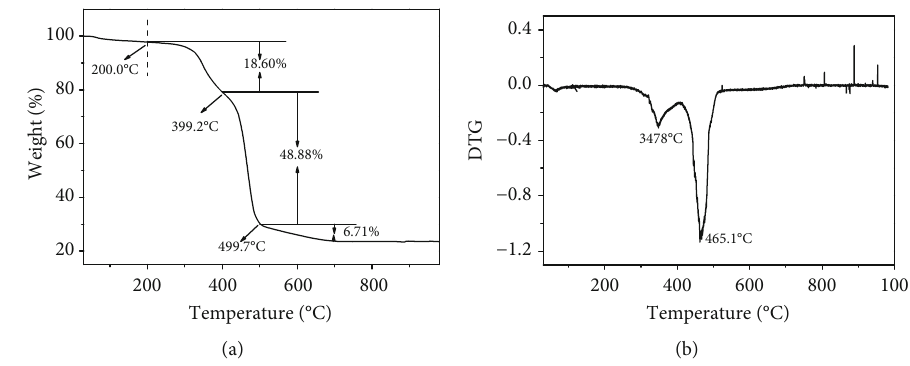
Figure 8: (a) TG and (b) DTG curves of the 10-UA-Tb(III) complex. Table 1: The curing time and properties of UV-cured fi